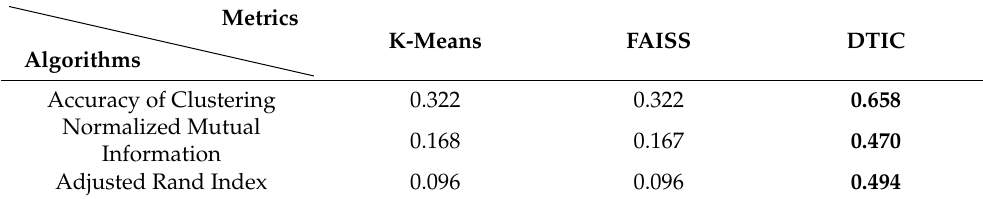
Figure 9. Quantity and percentage of each class on the Reunion Island Dataset using different methods implemented with averaged initial cluster centers. ( a ) FAISS; ( b ) K-means; ( c ) DTIC; ( d ) true proportion. Table 5. A comparison of different methods on the Imperial Dataset with random initial cluster centers. The bolded results show the best